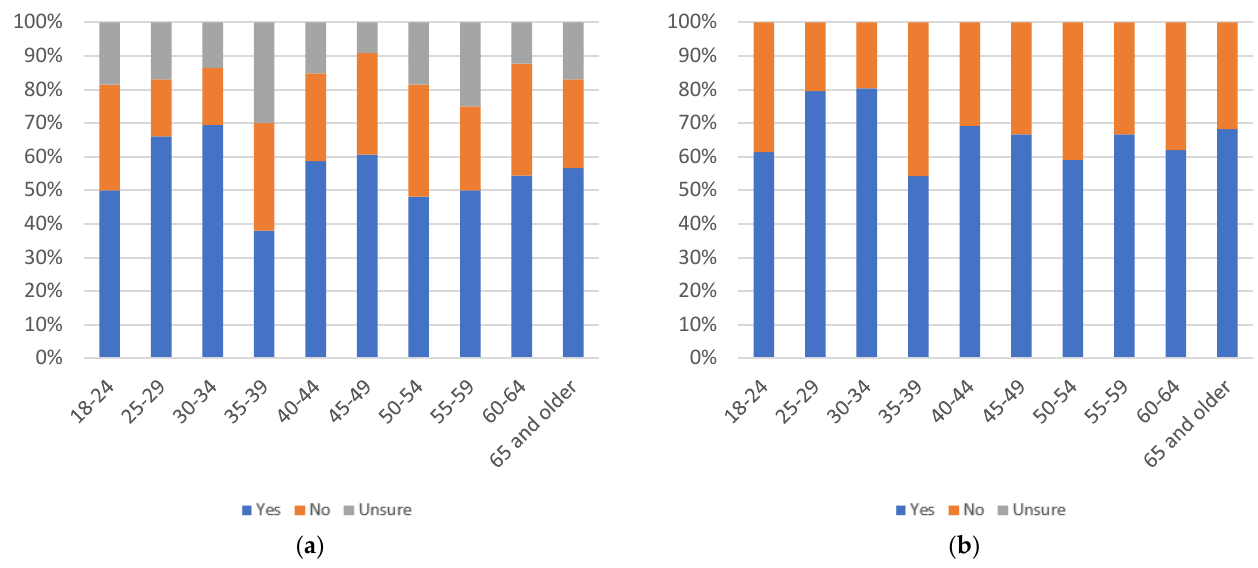
Figure 49. Label trustworthiness judging use, by age group: ( a ) with uncertain respondents (left) and ( b ) without uncertain respondents (right).